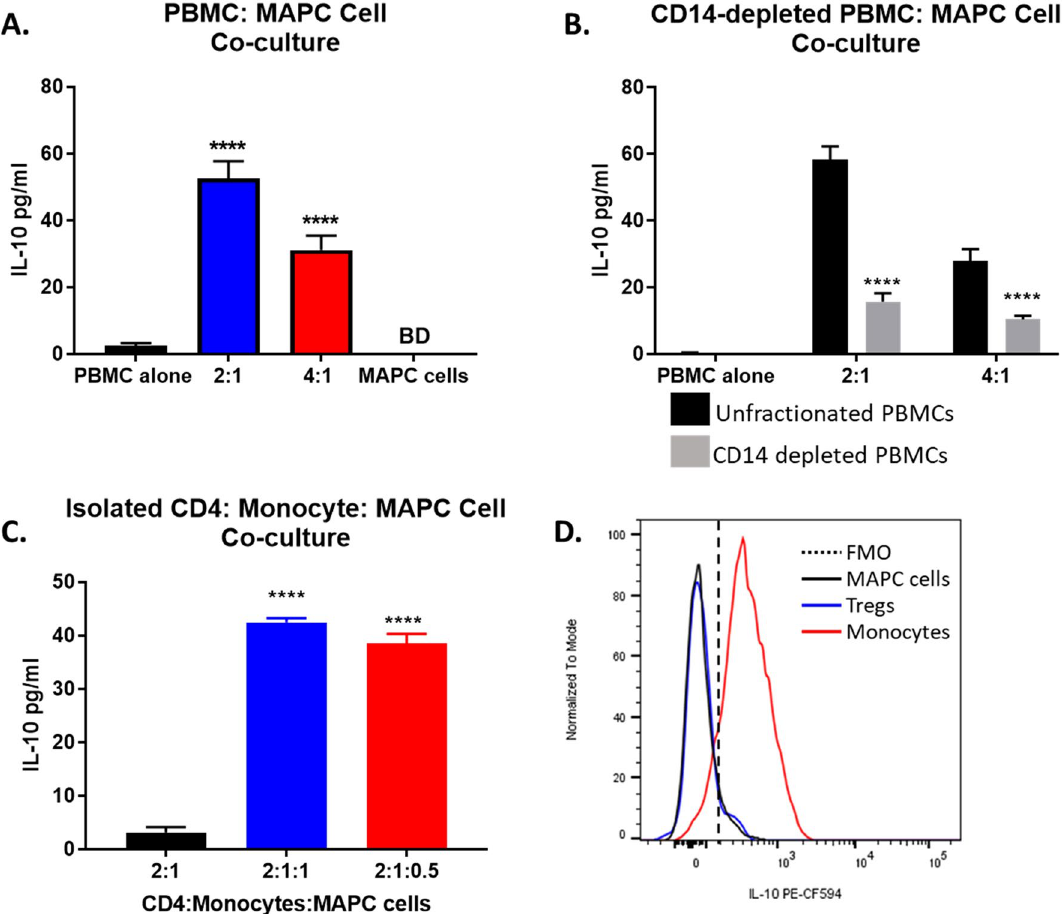
Figure 8. MAPC cells promotes monocyte secretion of IL-10. ( A ) IL-10 concentration in cultures supernatants of PBMC alone (black), 2:1 (blue) and 4:1 (red) PBMC:MAPC cells, and MAPC cells alone (gray) (BD, below detection) measured by ELISA. ( B ) IL-10 levels in supernatants collected from PBMCs (black) or CD14 depleted PBMCs (gray) cultured alone or with MAPC at 2:1 and 4:1 PBMC:MAPC ratios for 7 days measured by ELISA. Statistical analysis was performed using Two-way ANOVA with a Sidak’s multiple comparison test (****p < 0.0001) ( C ) IL-10 concentration in supernatants from cultures of isolated CD4 + T cells and CD14 + monocytes (2:1 CD4 + cell:CD14 + monocytes) with MAPC cells at 2:1:1 (blue) or 2:1:0.5 (red) measured by ELISA. Data represent mean ± SD from pooled samples of six independent experiments. Statistical analysis was performed using Two-way ANOVA with a Tukeys’s multiple comparisons test (****p < 0.0001). ( D ) Representative histogram depicting intracellular IL-10 expression on MAPC cells (black line), Tregs (blue), and monocytes (red). FMO control shown as dotted